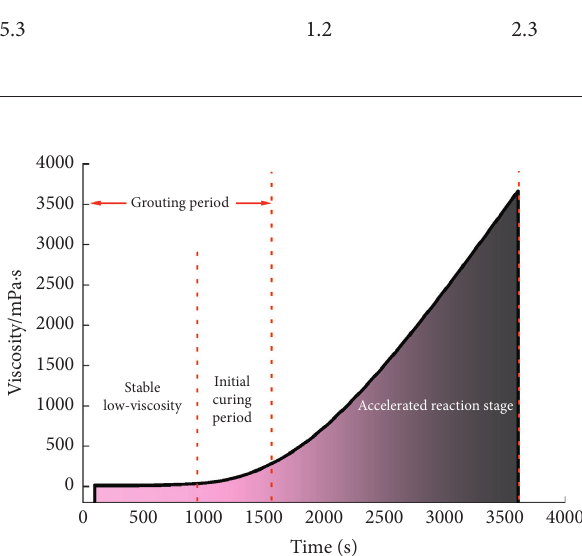
Figure 4: Schematic diagrams of viscosity changes with